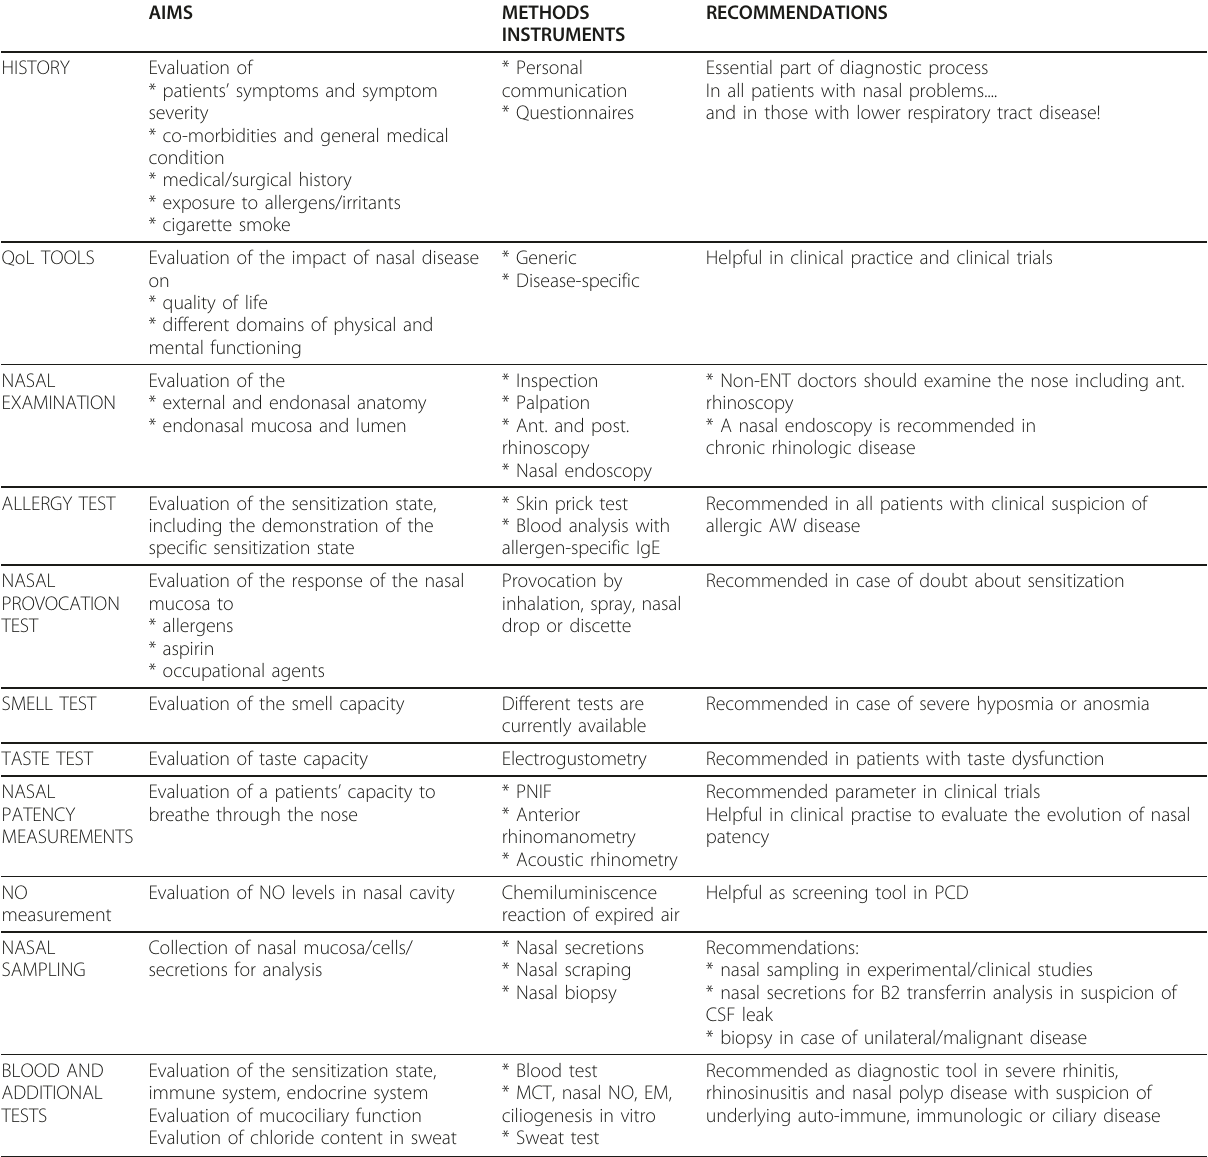
Table 7 Recommendations for diagnostic tools in rhinoloy